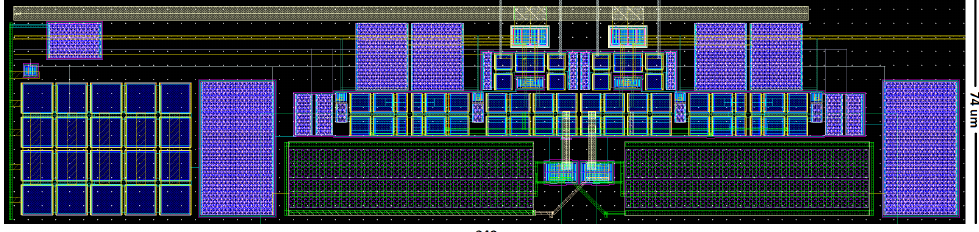
Figure 13. The layout of CRR front-end . Reprinted with permission from Ref. [12]. Copyright 2022, Frederic Nabki.